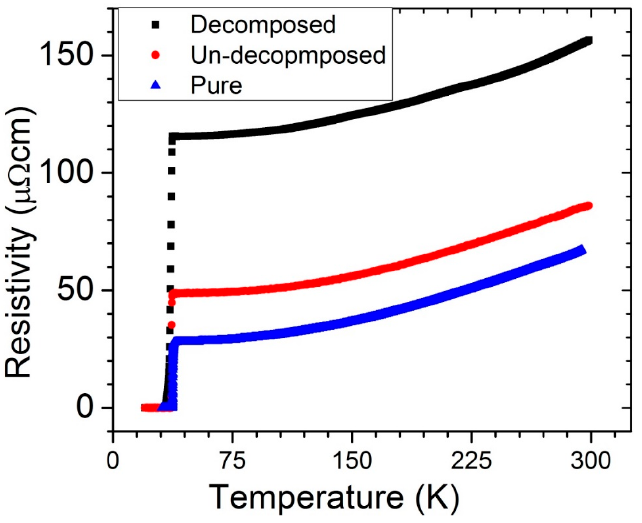
Figure 7. The resistivity of the CNTs ‐ MgB 2 composite as a function of the temperature.